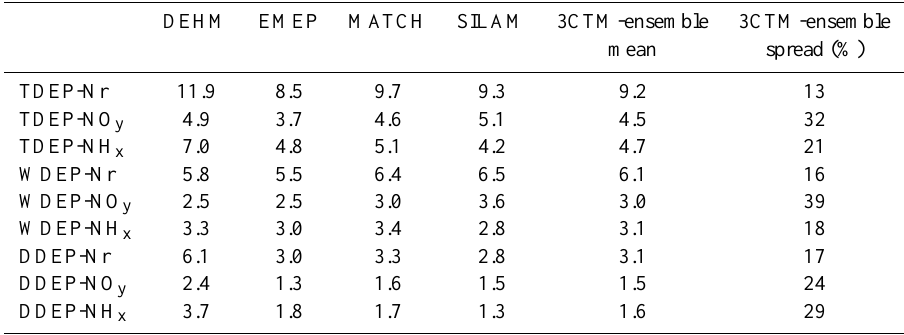
Table 5. Base-case depositions of Nr components (kg ( N ) ha − 1 ) for the four CTMs, along with the 3CTM-ensemble mean and spread. Values are average depositions over the EU28 + domain.